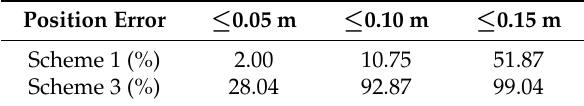
Table 4. Statistical analysis of the horizontal position error probability.